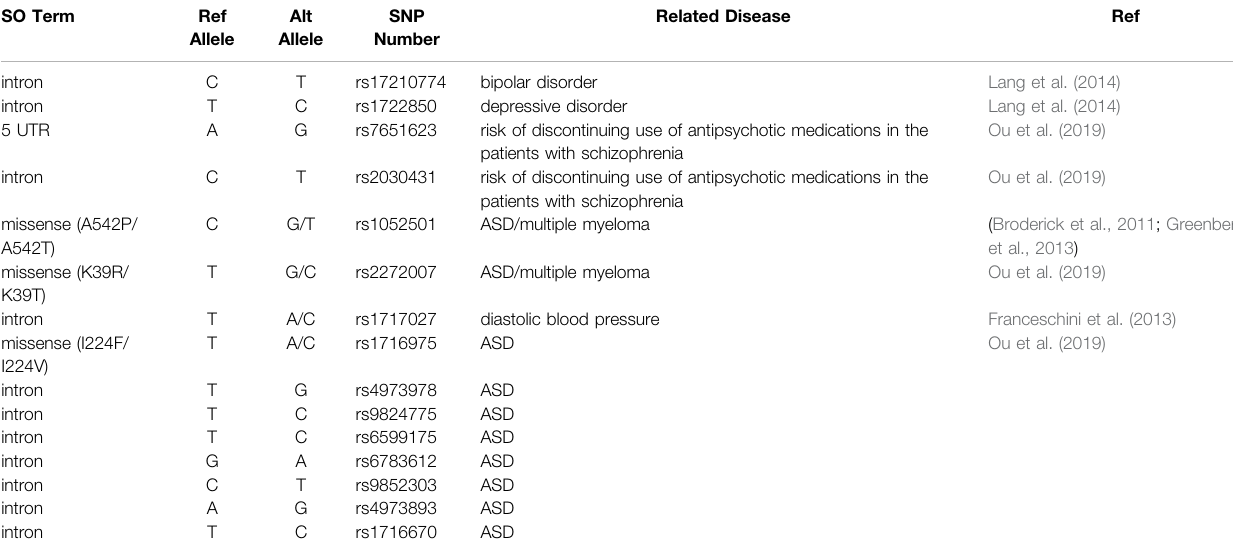
TABLE 1 | Summary of ULK4 variants and relevant manifestation in human patients. SO Term